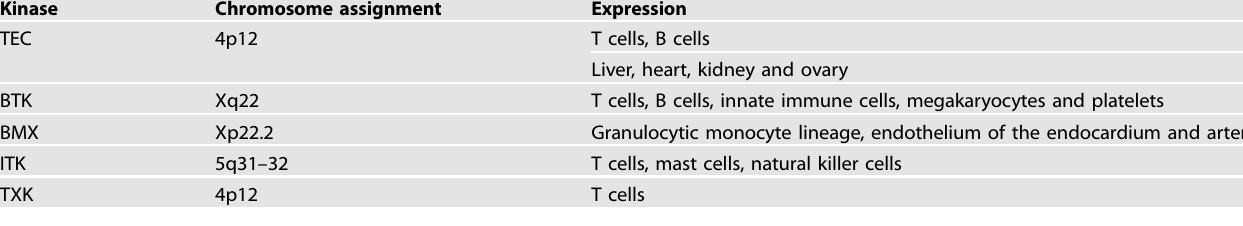
Table 2. The Tec family kinases functions and regulation. Kinase